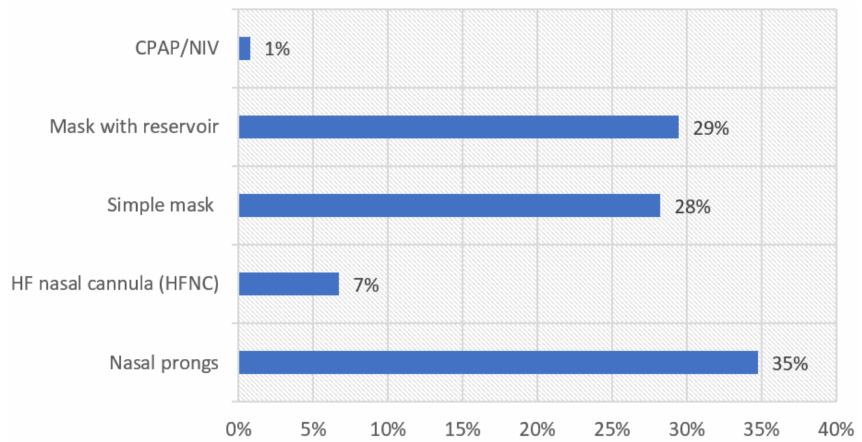
Figure 5. Respiratory support for hospitalised COVID-19 patients in Limpopo Province.